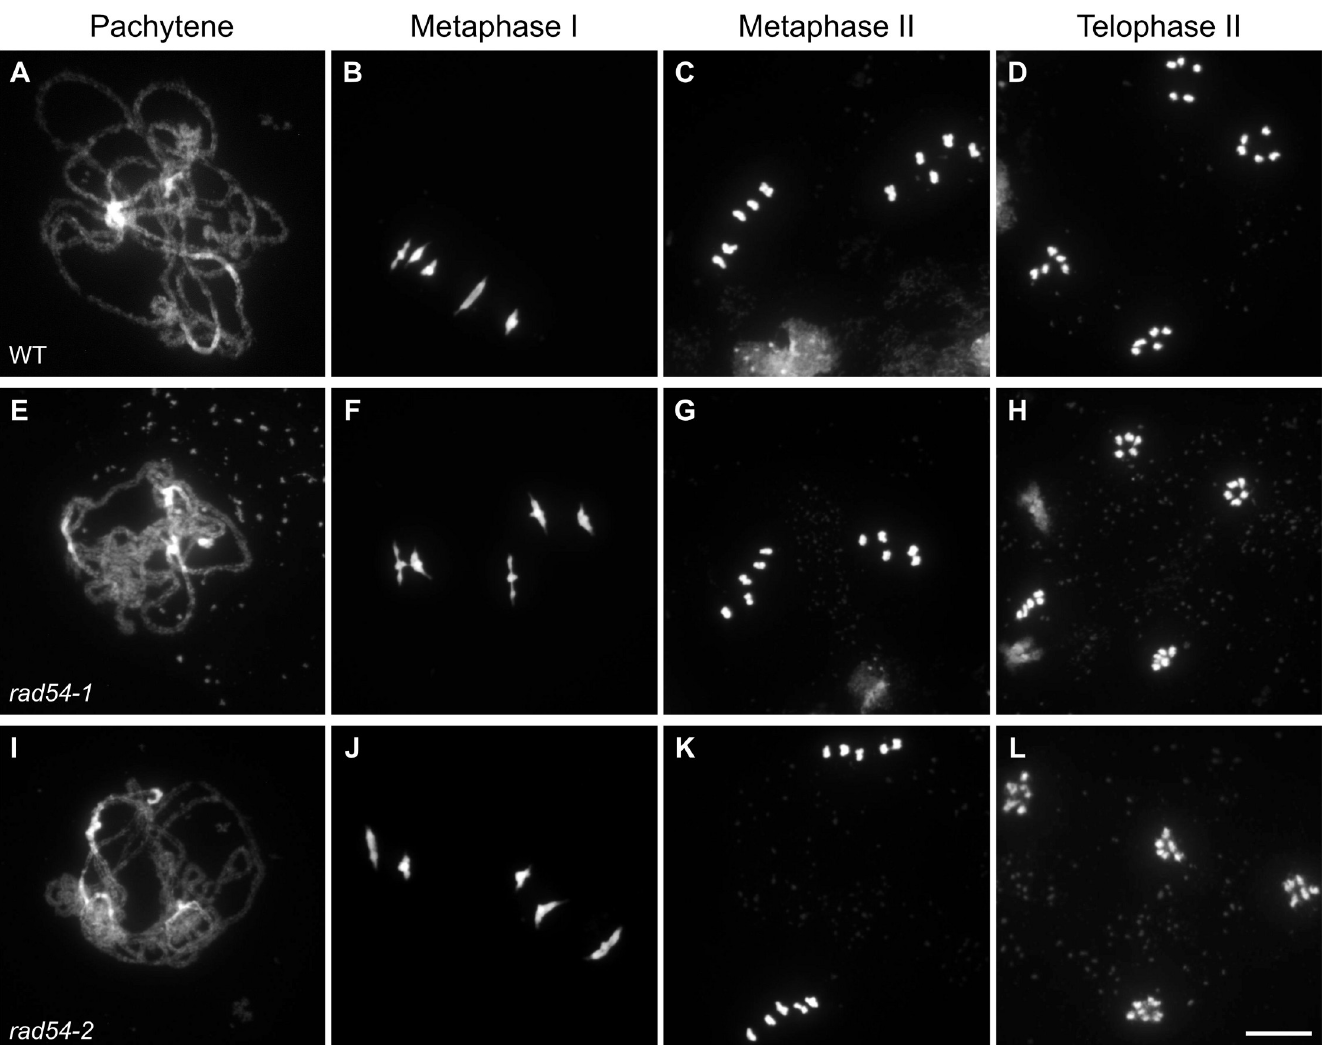
Fig 2. Both rad54-1 and rad54-2 mutants have WT meiosis. Chromosome spreads of male meiocytes in wild type (A-D), rad54-1 (E-H) and rad54-2 (I-L). Pachytene (A,E,I); Metaphase I (B,F,J); Metaphase II (C,G,K); Telophase II (D,H,L). Chromosomes were spread and stained with DAPI. (Scale bar = 10 μ